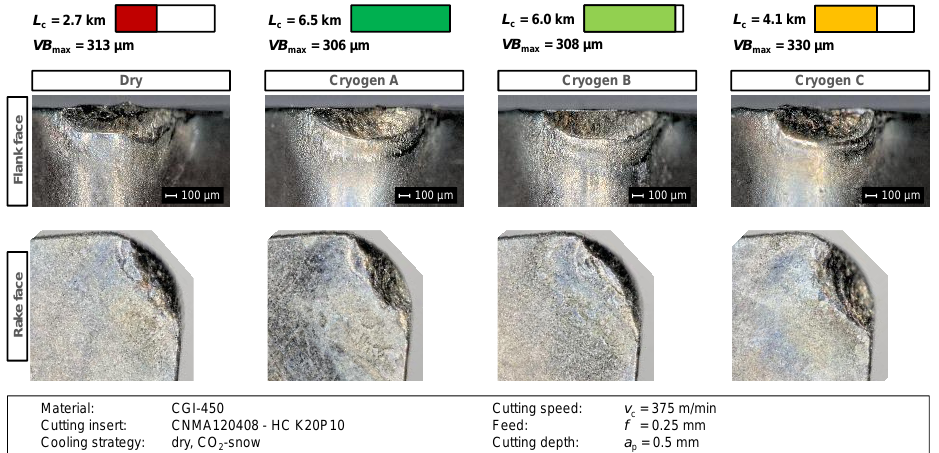
Figure 7. Signs of wear after reaching the abort criteria when using CO 2 -snow compared to dry machining.